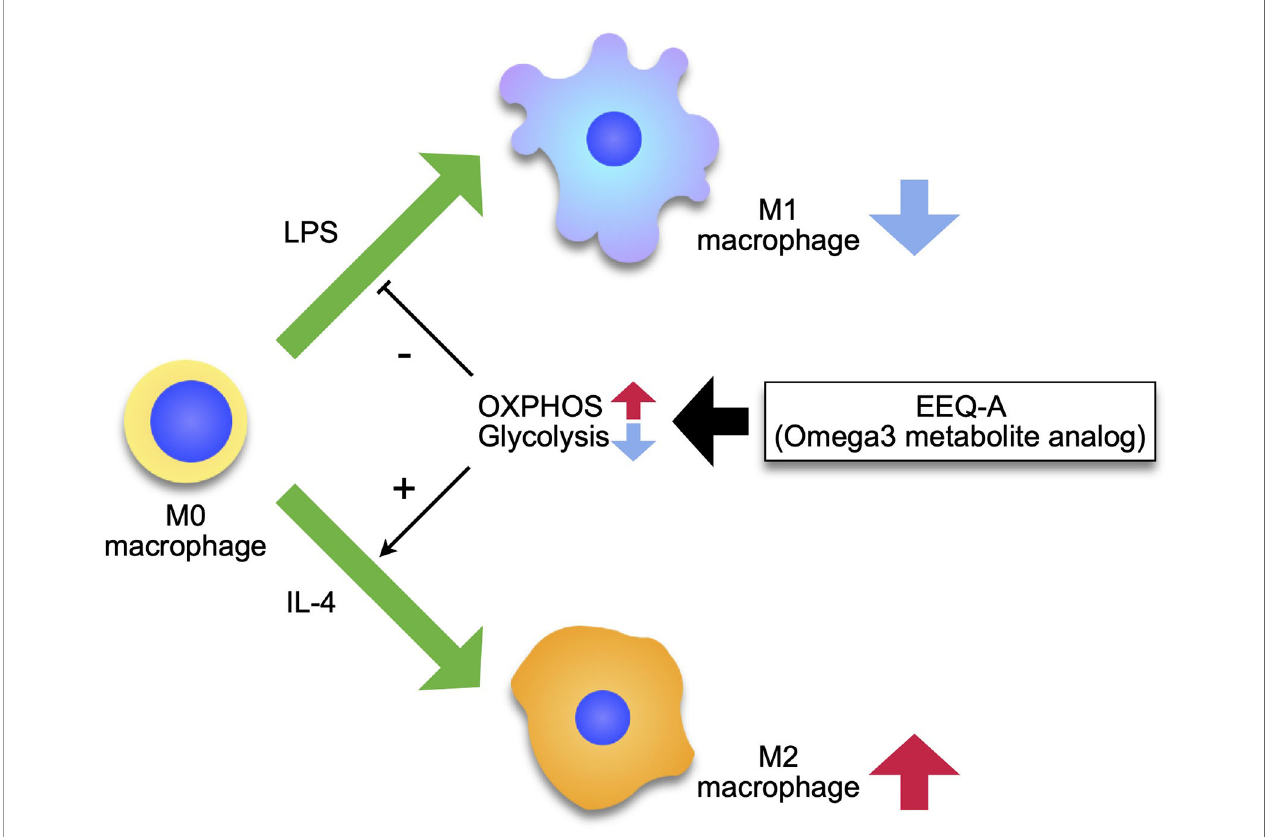
FIGURE 6 | Model of the effect of EEQ-A on macrophages. Macrophages differentiate into M1 or M2 by external stimuli, and this process is regulated by metabolism, with M1 depending on the glycolysis for energy and M2 being maintained by the mitochondrial respiratory chain activity. EEQ-A has a metabolism- targeted mode of action, suppressing the glycolysis and enhancing OXPHOS, thereby inhibiting differentiation to M1 and promoting differentiation to